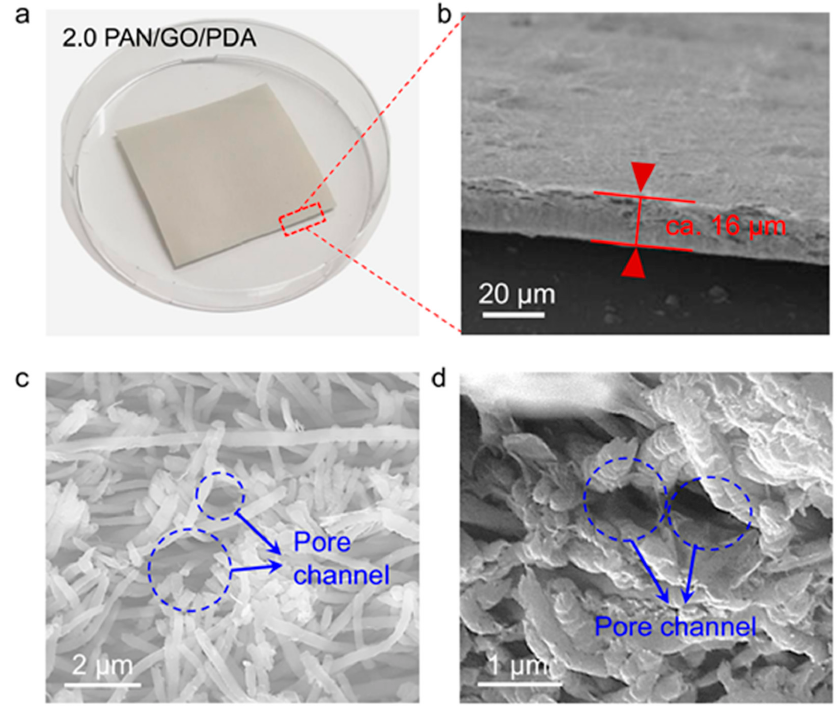
Figure 3. ( a ) Optical photograph of the 2.0 PAN/GO/PDA membrane. ( b – d ) Cross-sectional SEM images of the 2.0 PAN/GO/PDA membrane. Scale bars: ( b ) 20 μ m; ( c )2 μ m; ( d ) 1 μ m.